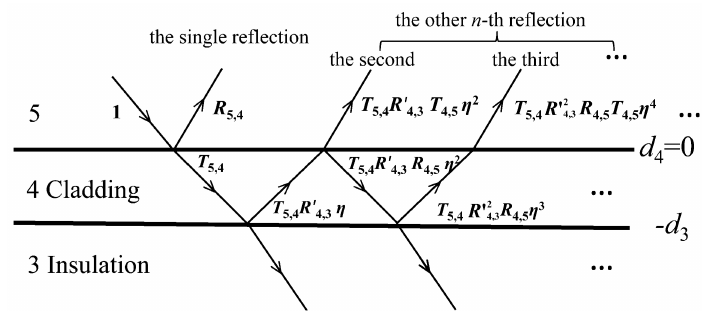
Figure 2. The reflections and transmissions in layers 4 and 5. Figure 2 indicates that R (cid:48) 5,4 ( α ) is the sum of the single reflection coefficient and the other n -th reflections whose general expression is T 5,4 R (cid:48) ( n − 1) 4,3 R (n − 2) 4,5 T 4,5 η 2(n − 1)